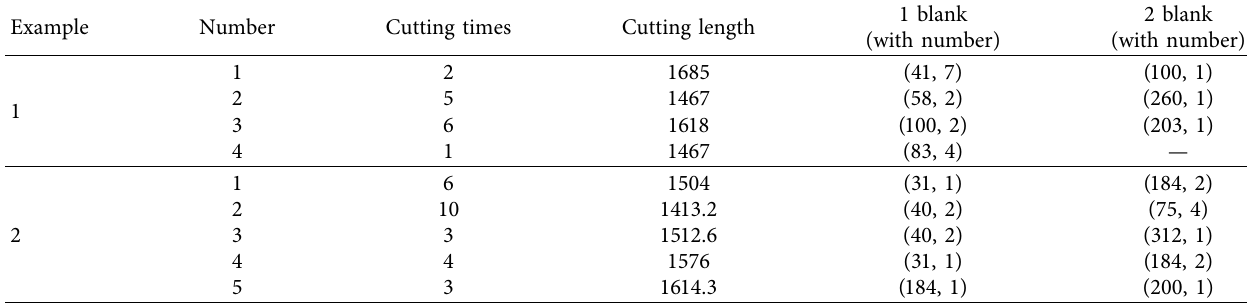
Table 4: Blanking scheme.